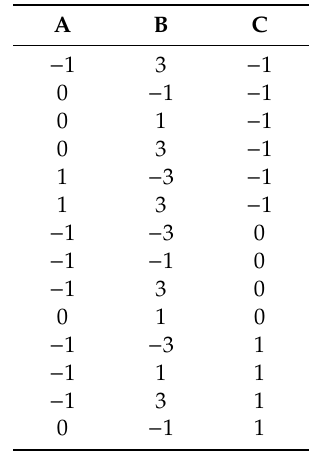
Table 7. Experimental matrix with factors A, B and